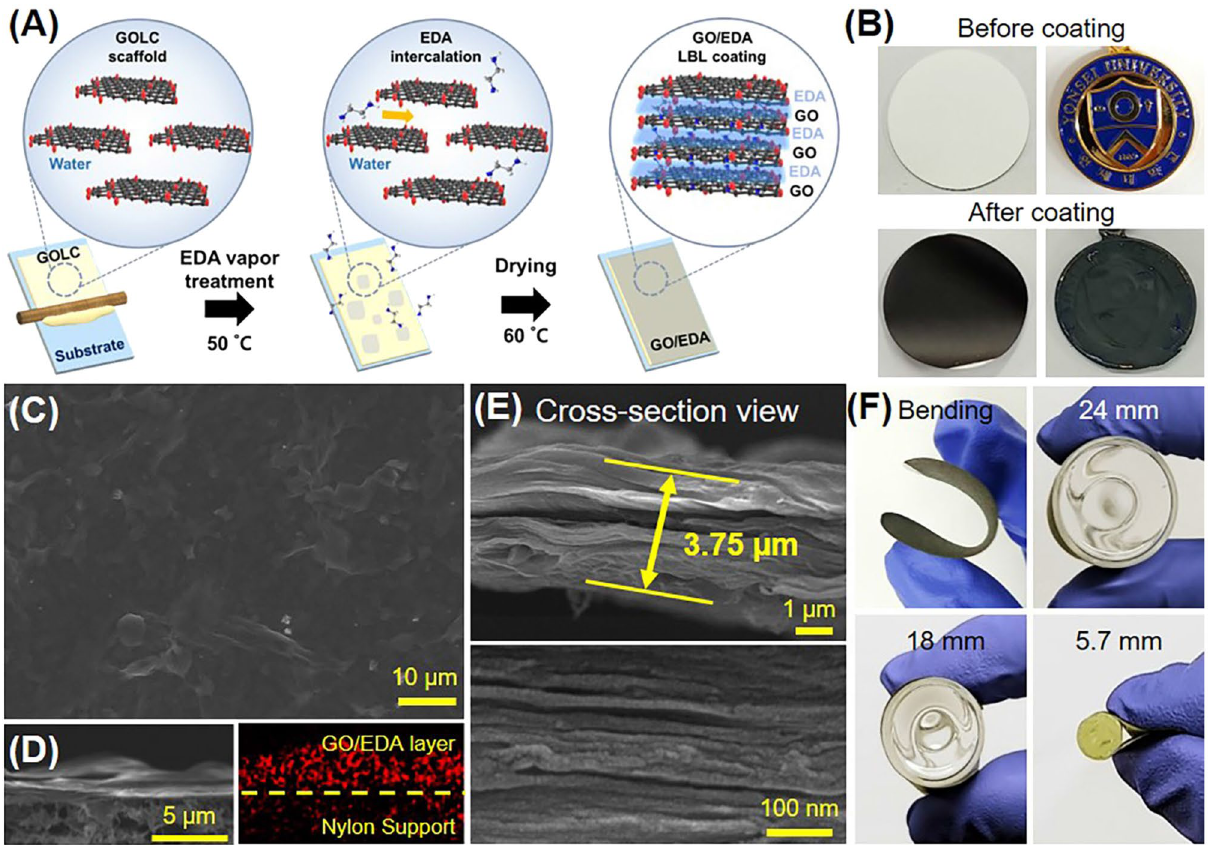
Figure 1. ( A ) Schematic illustration of GO/EDA coating procedure on the target substrate. ( B ) Photographic images of a nylon substrate and a souvenir before and after GO/EDA coating. ( C , D ) Top-view, and cross- sectional SEM images of a GO/EDA coating on a nylon substrate. The right image of ( D ) is EDS mapping image for nitrogen. ( E ) Magnified cross-sectional SEM images of GO/EDA coating. ( F ) Bending test of GO/EDA coated a nylon substrate at several bending diameters. The EDA exposure time was 1